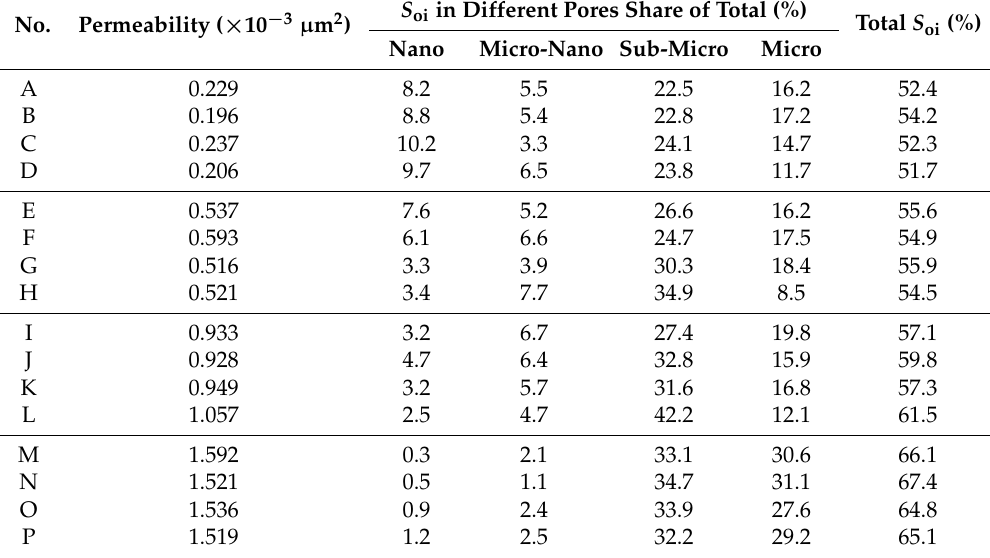
Table 3. Oil saturations of the cores saturated with the crude